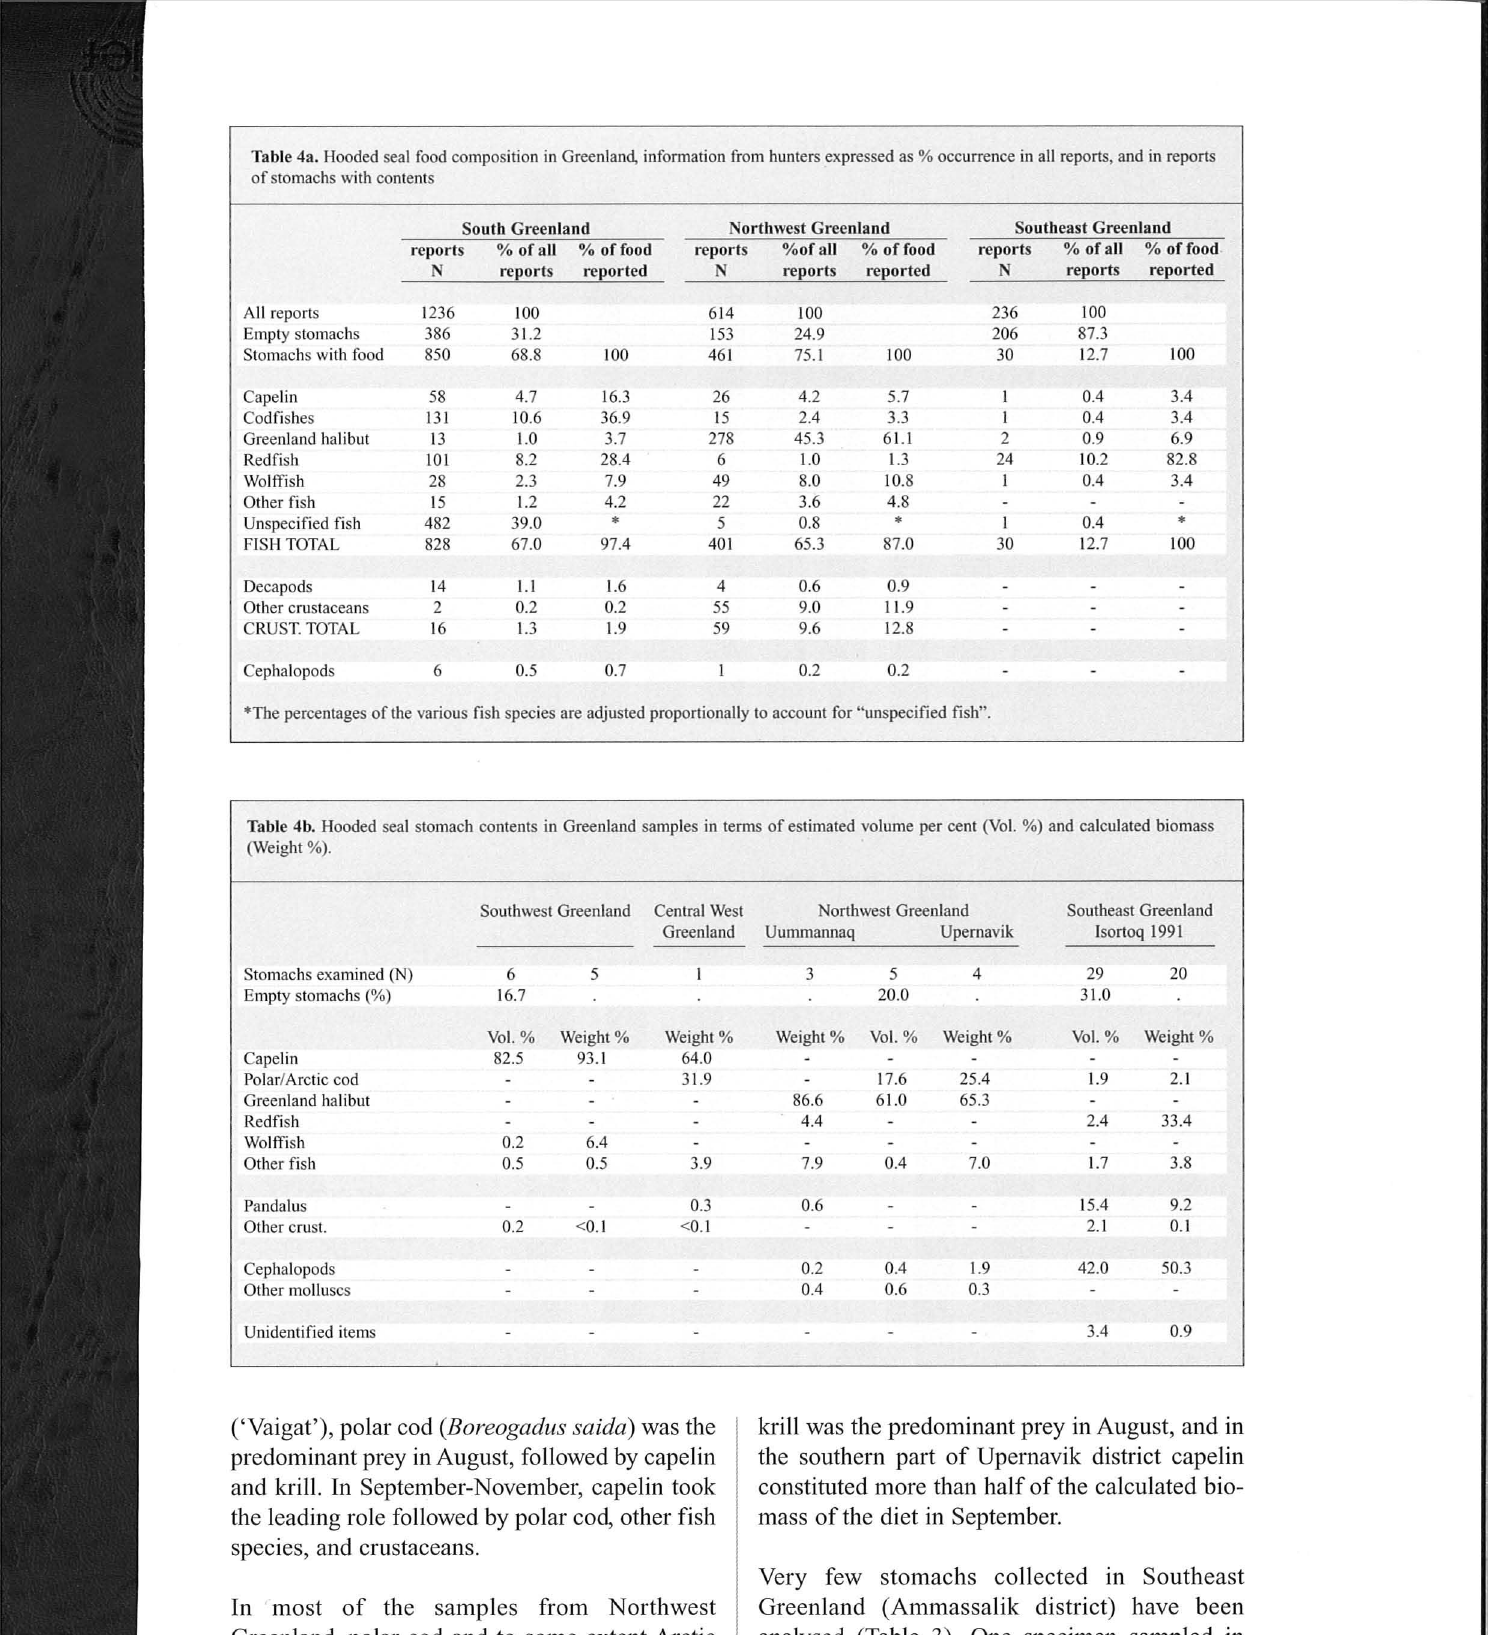
Table 4a. Hooded seal food composition in Greenland, information from hunters expressed as % occurrence in all reports, and in reports of stomachs with contents